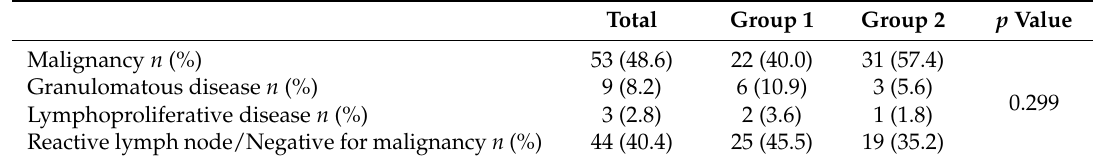
Table 5. EBUS-TBNA